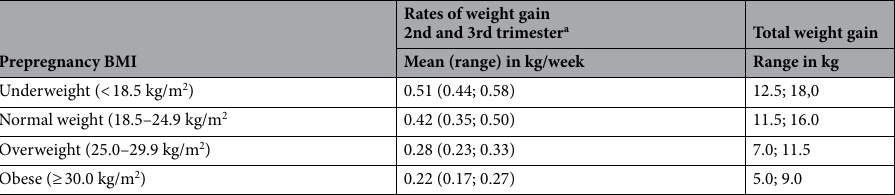
Table 4. Institute of Medicine guidelines for total and rate of weight gain during pregnancy, according to pre- pregnancy BMI. a Considering a weight gain range of 0.5; 2 kg in the first trimester. Adapted from IOM 34